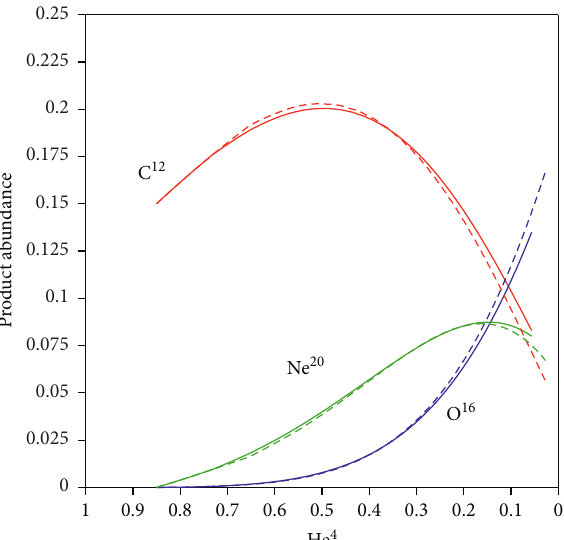
Figure 4: The product abundance (C 12 , O 16 , and Ne 20 ) computed analytically at X fractional parameters. The solid lines represent the helium network with α � 0 . 9 and the dashed lines represent the helium network α � 0 . 5.